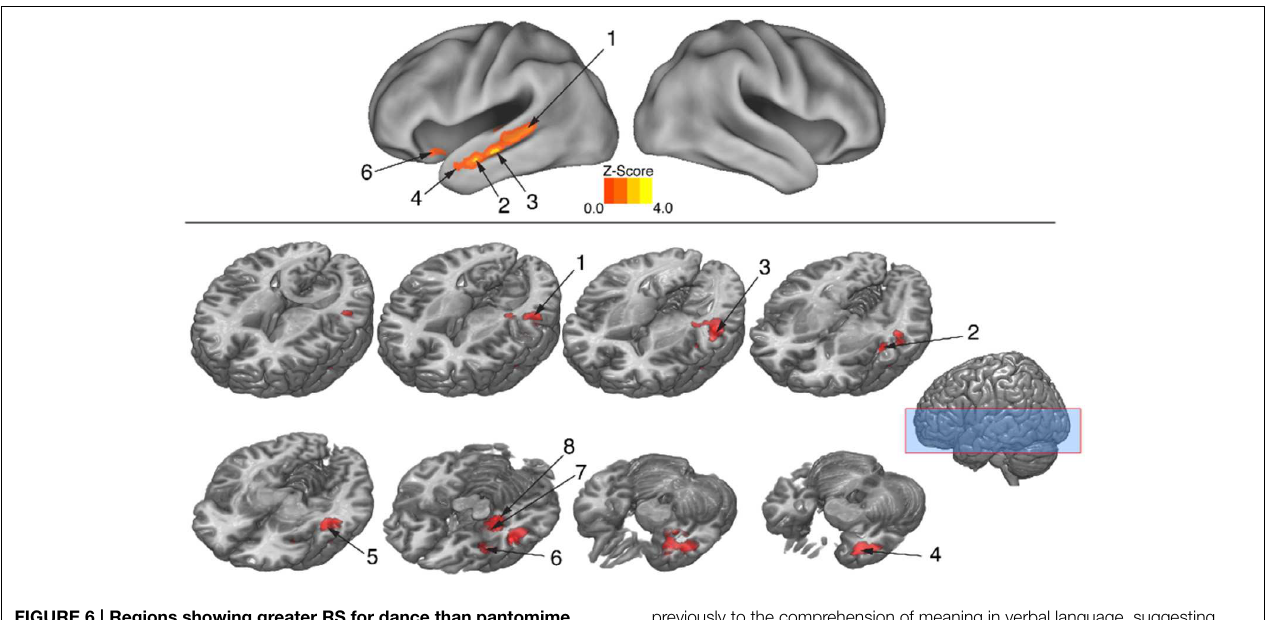
FIGURE 6 | Regions showing greater RS for dance than pantomime. RS effects were compared between movement types. This was implemented as an interaction contrast within our Movement Type × Repetition ANOVA design [(Novel Dance > Repeated Dance) > (Novel Pantomime > Repeated Pantomime)]. Greater RS for dance was lateralized to left hemisphere meaning-sensitive regions. The brain areas shown here have been linked